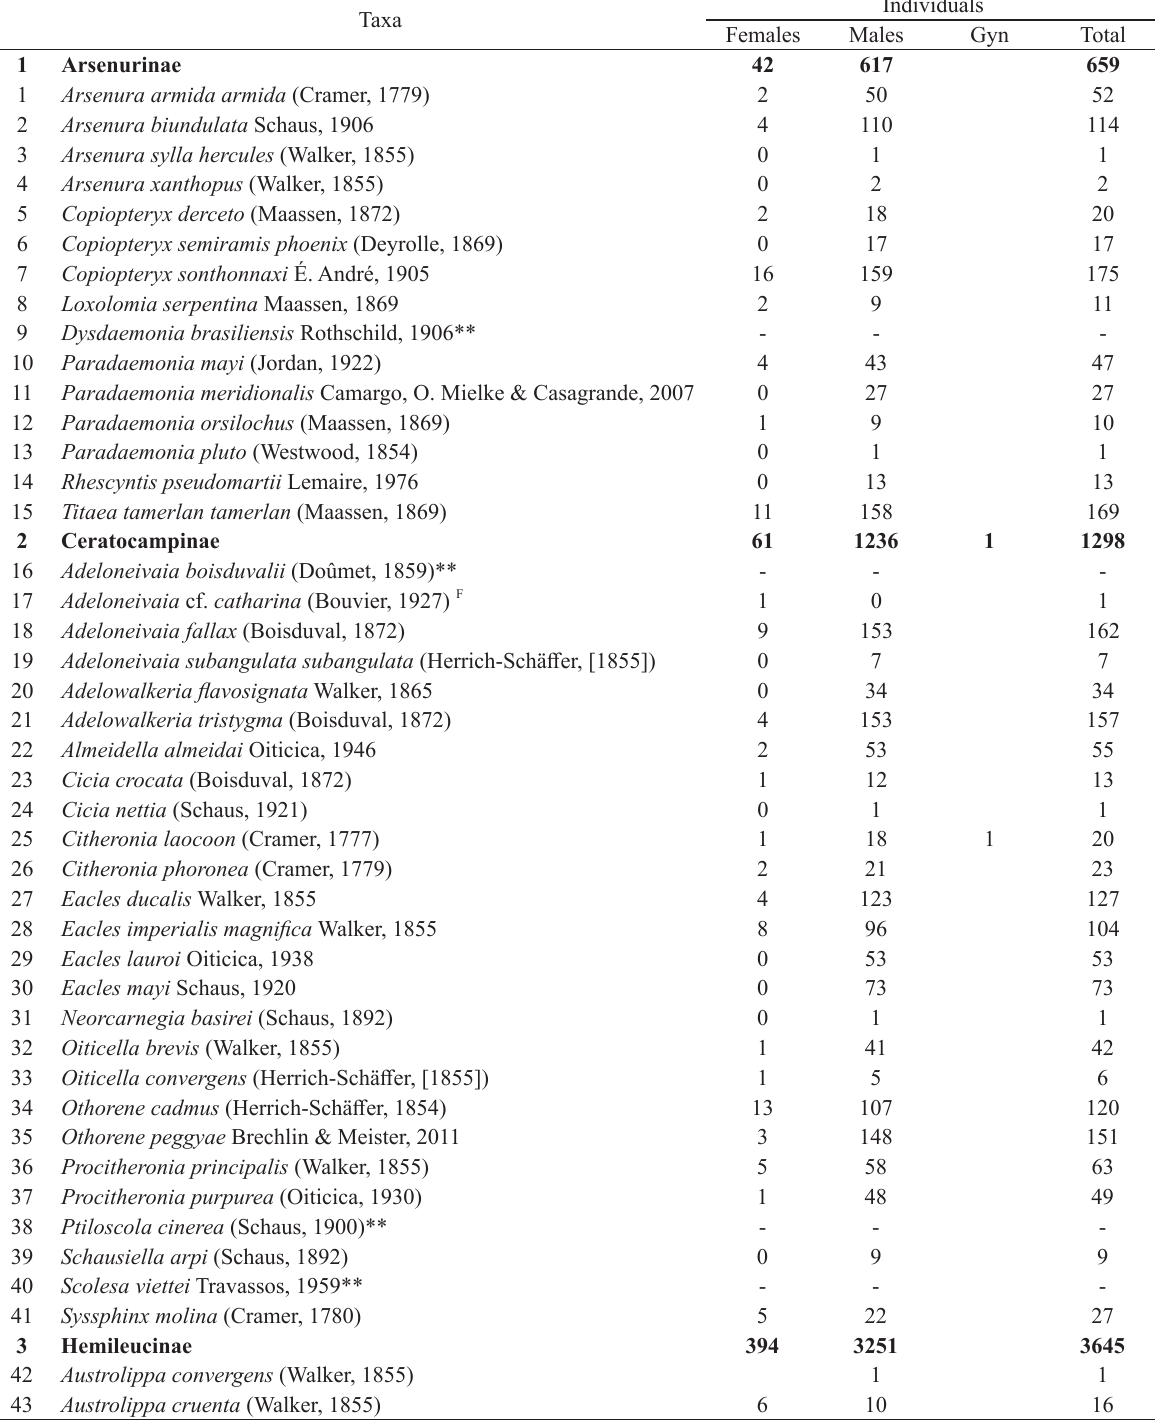
Species of Saturniidae (Lepidoptera) collected between 1942 and 2013 from the Boraceia Biological Station, São Paulo, Brazil. Voucher material is deposited in the MZSP collection or was listed by Miranda et al. (2015). Gyn =